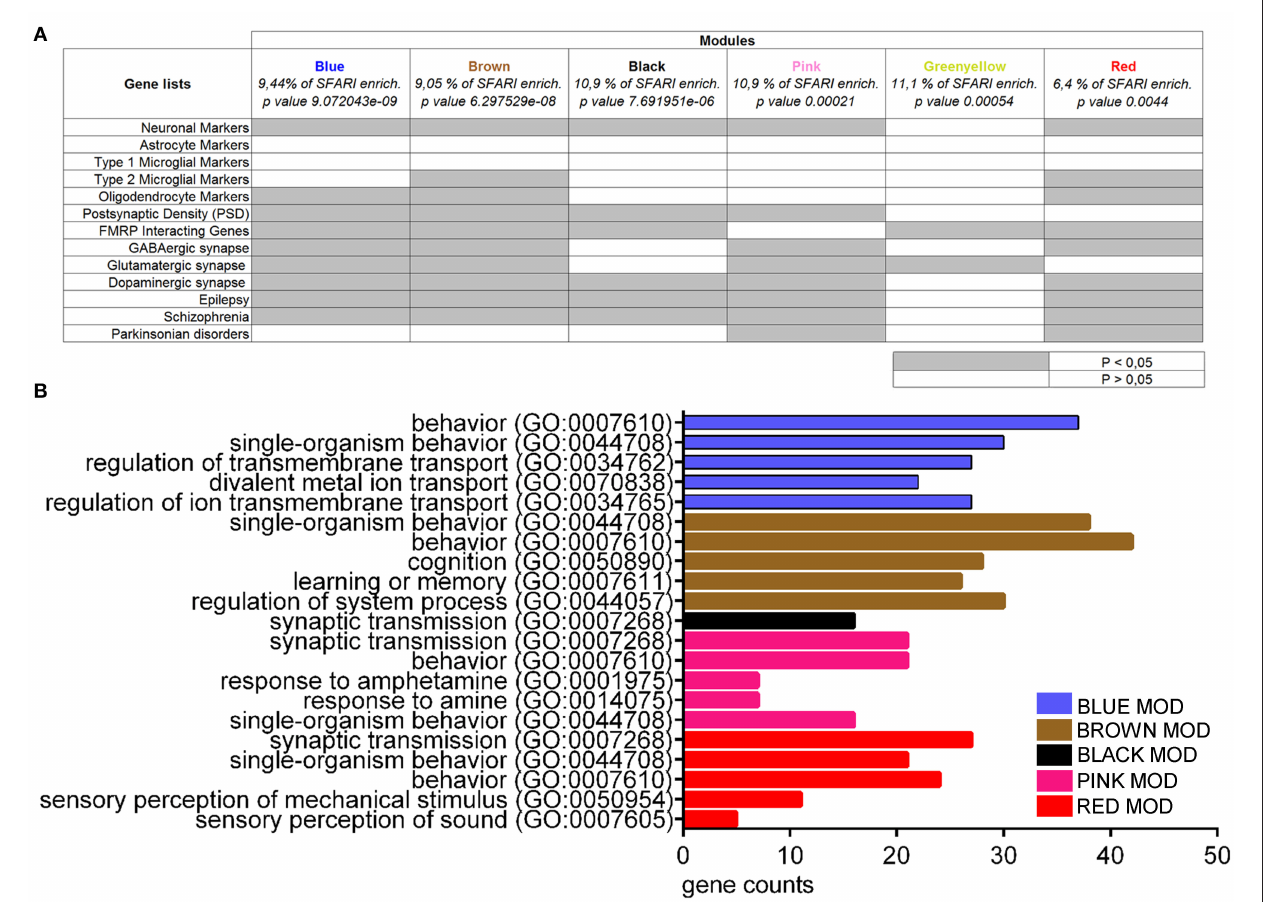
FIGURE 6 | Enrichment and gene ontology analyses on co-expression modules resulting from WGCNA on BTBR and En2 − / − hippocampal DEGs. (A) Co-expression modules enriched in SFARI genes were analyzed for enrichment in genes belonging to specific categories relevant to the autistic phenotype, as indicated. Gene lists were as in Figure 5 . Significance of enrichment is indicated (white, p > 0.05; gray, p < 0.05). (B) Co-expression modules were analyzed for enrichment in GO categories using Enrichr, with an adjusted p < 0.05. For each category, the number of genes is indicated by the length of horizontal bars (gene counts). Modules are indicated in their respective colors. The Greenyellow module is not indicated in the graph since it did not show any significant over-representation of GO